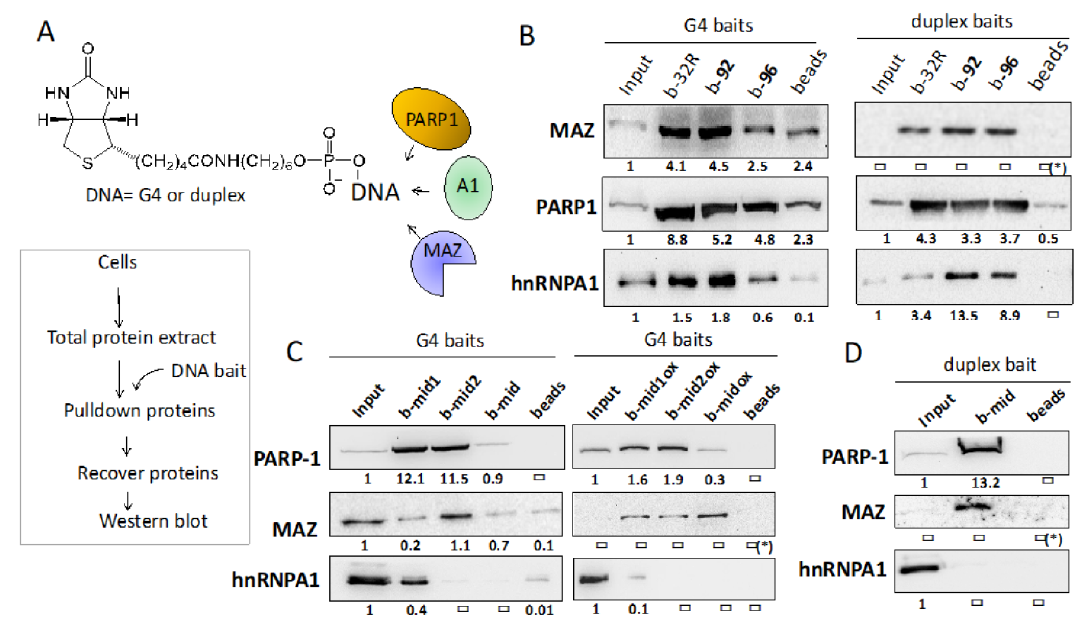
Figure 4. ( A ) Structure of the DNA baits used in the pull-down experiments. The scheme of the pull-down experiments is illustrated; ( B ) Pull-down with wild-type and oxidized G4 32R sequence in the G4 or duplex conformation. b-32R is wild-type G4 32R, while b- 92 bears one 8OG in a G-run, b- 96 bears two 8OG bases in the 12-nt loop (see structure in ref [35]) (Table 1). The biotinylated G4 or duplex baits (80 nM) were incubated with 80 µ g of nuclear extract for 30 min at RT. The DNA bait-protein complexes formed were pulled down with streptavidin magnetic beads. The pulled-down proteins were recovered and analyzed by Western blot with anti MAZ, anti PARP-1 and anti hnRNP A1 primary antibodies and a secondary antibody conjugated to horseradish peroxidase; ( C , D ) Pull-down with wild-type G4 mid sequences b-mid, b-mid1 and b-mid2 or oxidized b-midox, b-mid1ox and b-mid2ox, in G4 or duplex conformation. The protocol followed is the same as in ( B ). We reported below each Western blot the band / input ratios. The uncertainty of these values from two experiments is about 20%; (*) = the band / input ratios could not be determined.